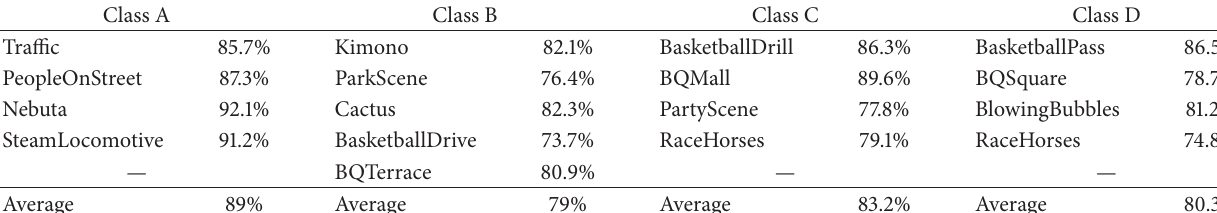
Table 1: The probability of 2𝑁 × 2𝑁 PU as the best mode.